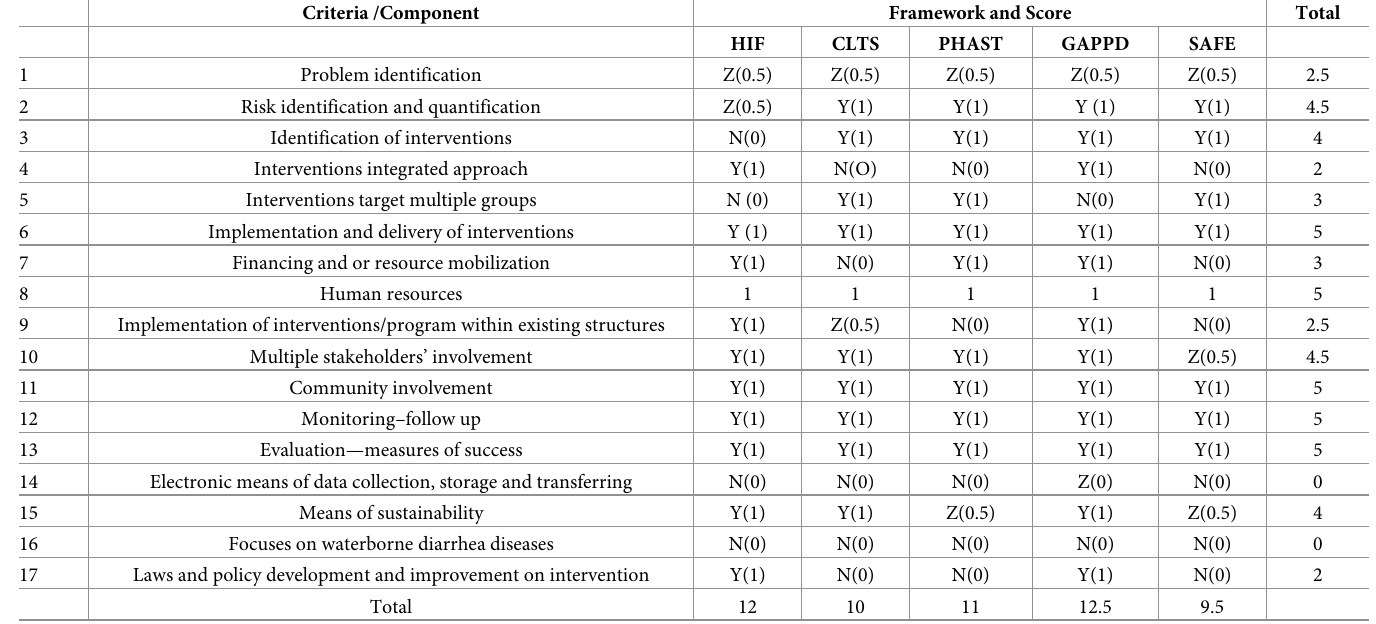
Table 3. Strengths and weaknesses of frameworks for mitigating the risks of diarrheal